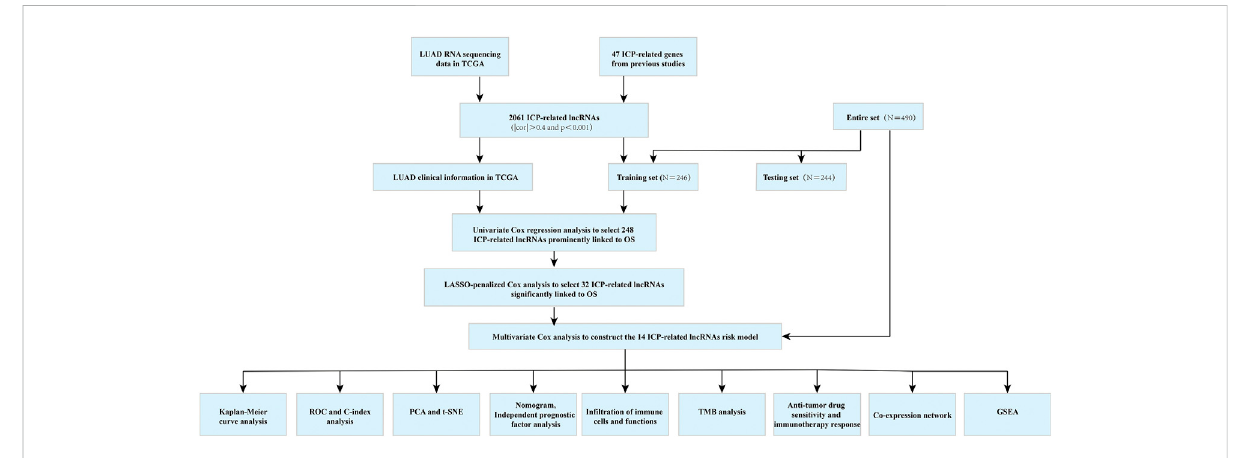
FIGURE 1 Work fl ow chart.